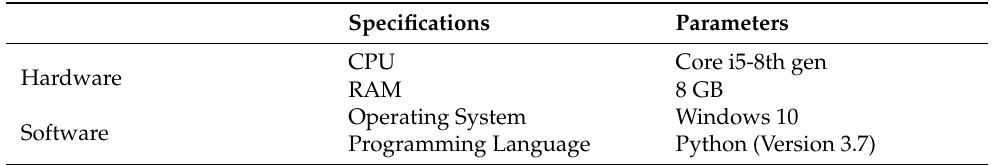
Table 2. Hardware and software